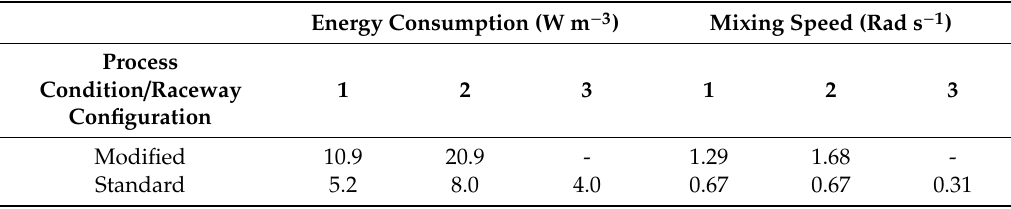
Table 7. Paddlewheel rotation speed and associated energy